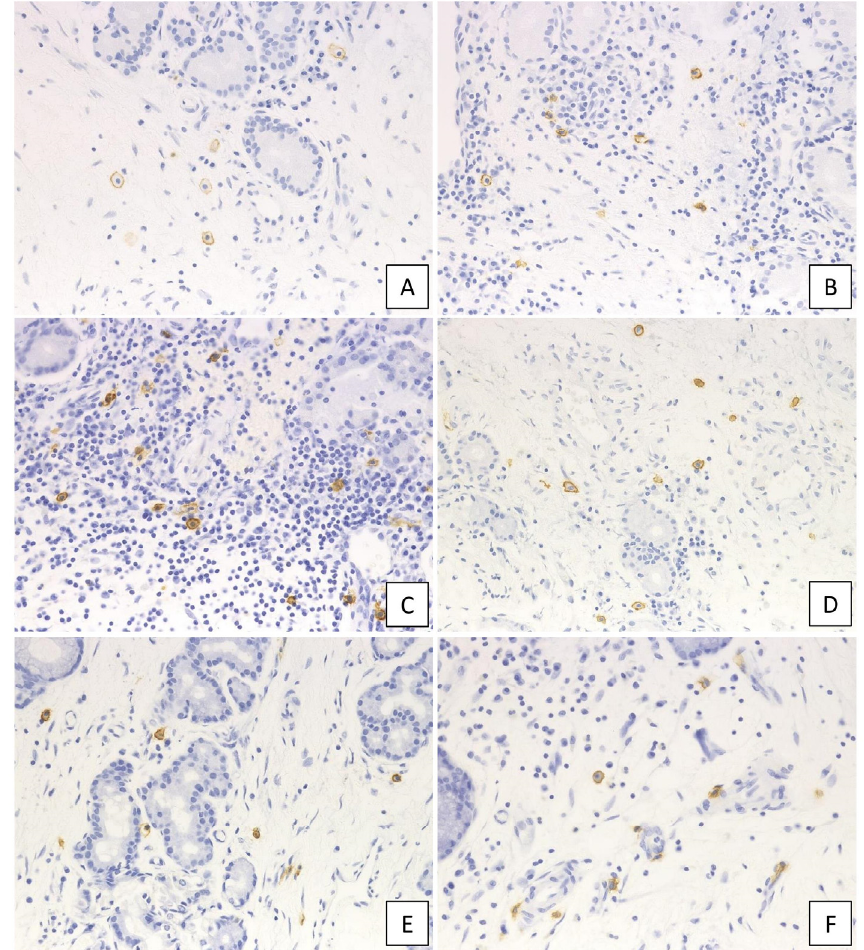
Figure 2. Immunohistochemical staining of c-kit in the diseased tissue. ( A ) non-CRS, ( B ) CRSsNP, ( C ) non-ECRS, ( D ) mild ECRS, ( E ) moderate ECRS, and ( F ) severe ECRS. The surface membrane of mast cells was positive for c-kit (400 × magnification).